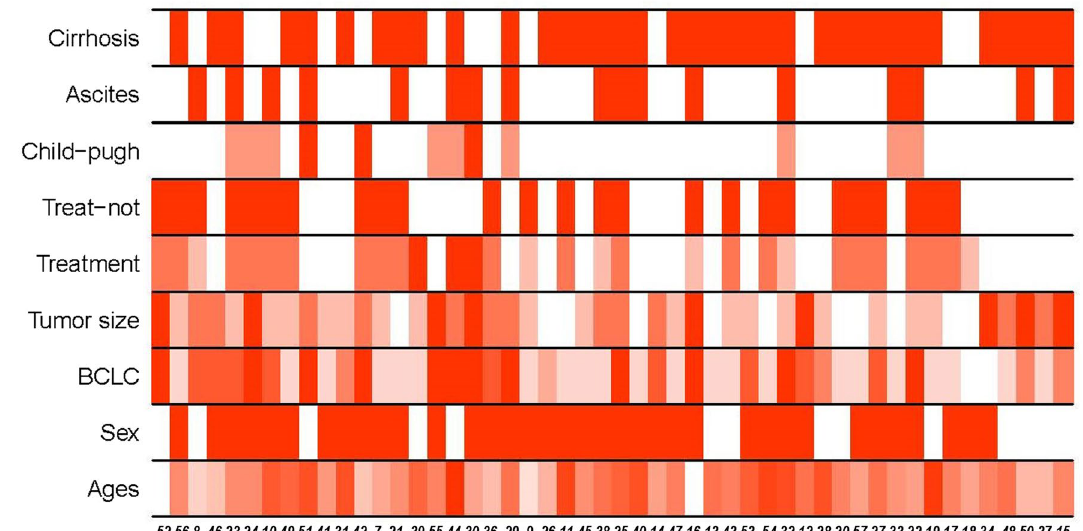
Figure 2. Clinical characteristics of HCC samples, it was created using R version 4.0.2, https:// www.r- proje ct. org/. For PBMCs was collected from patients with HCC (17 samples for sequencing and 33 samples for validation). Shown, in descending order, are whether cirrhosis, whether ascites, classification of Child–Pugh, whether treatment or not, treatment method, tumor size, BCLC classification, sex and ages of those patients at time of sampling. The graph was created using R version 4.0.2 (https:// www.r- proje ct.